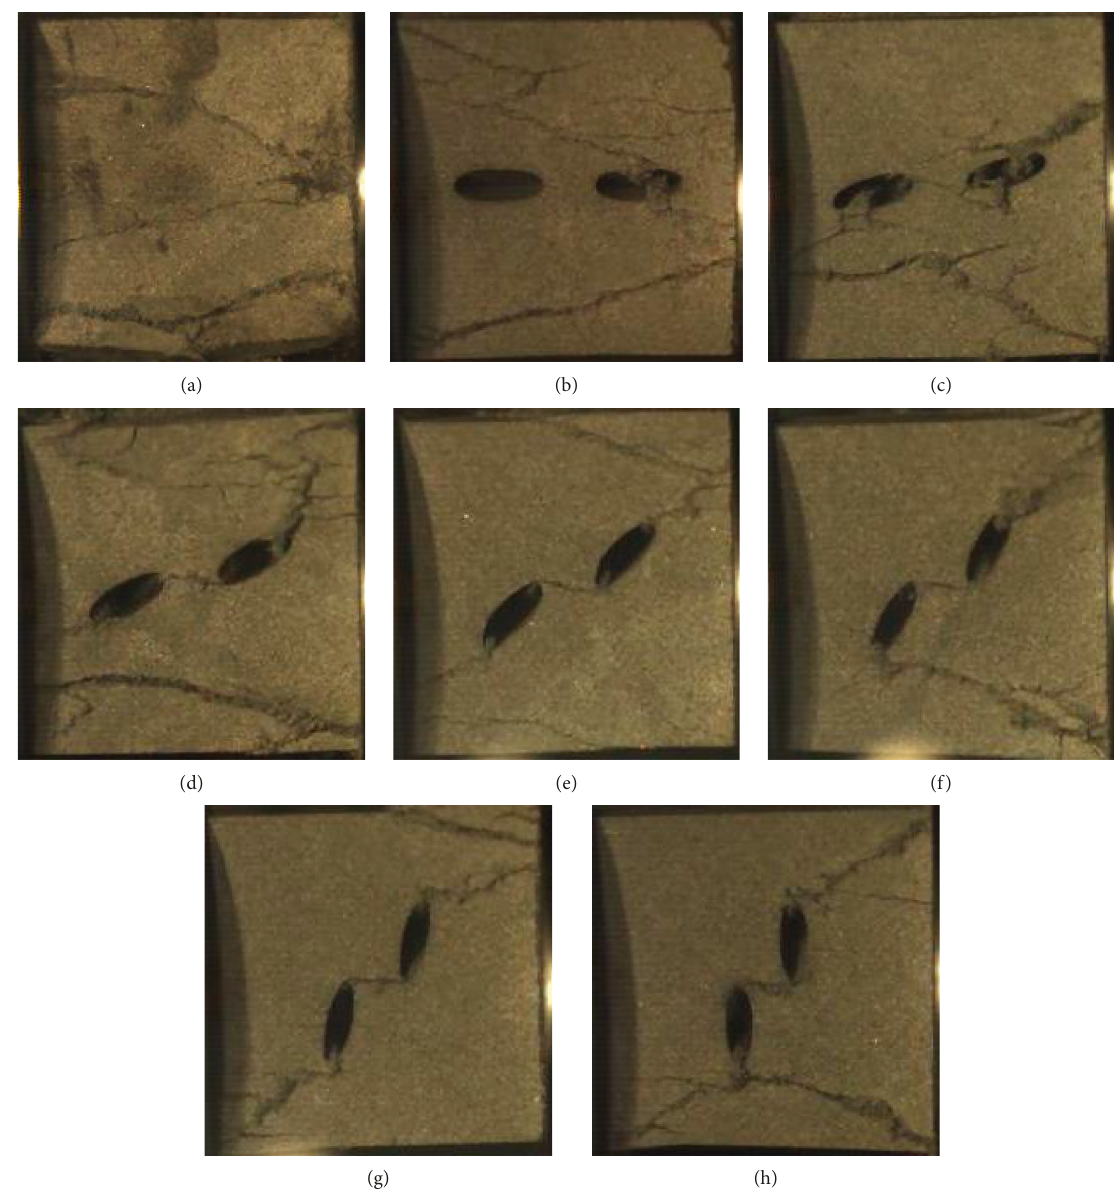
Figure 13: Effect of the flaw inclination angle on the final failure patterns of defected sandstone specimens under dynamic loading. (a) Intact. (b) S-0-0. (c) S-15-0. (d) S-30-0. (e) S-45-0. (f) S-60-0. (g) S-75-0. (h)